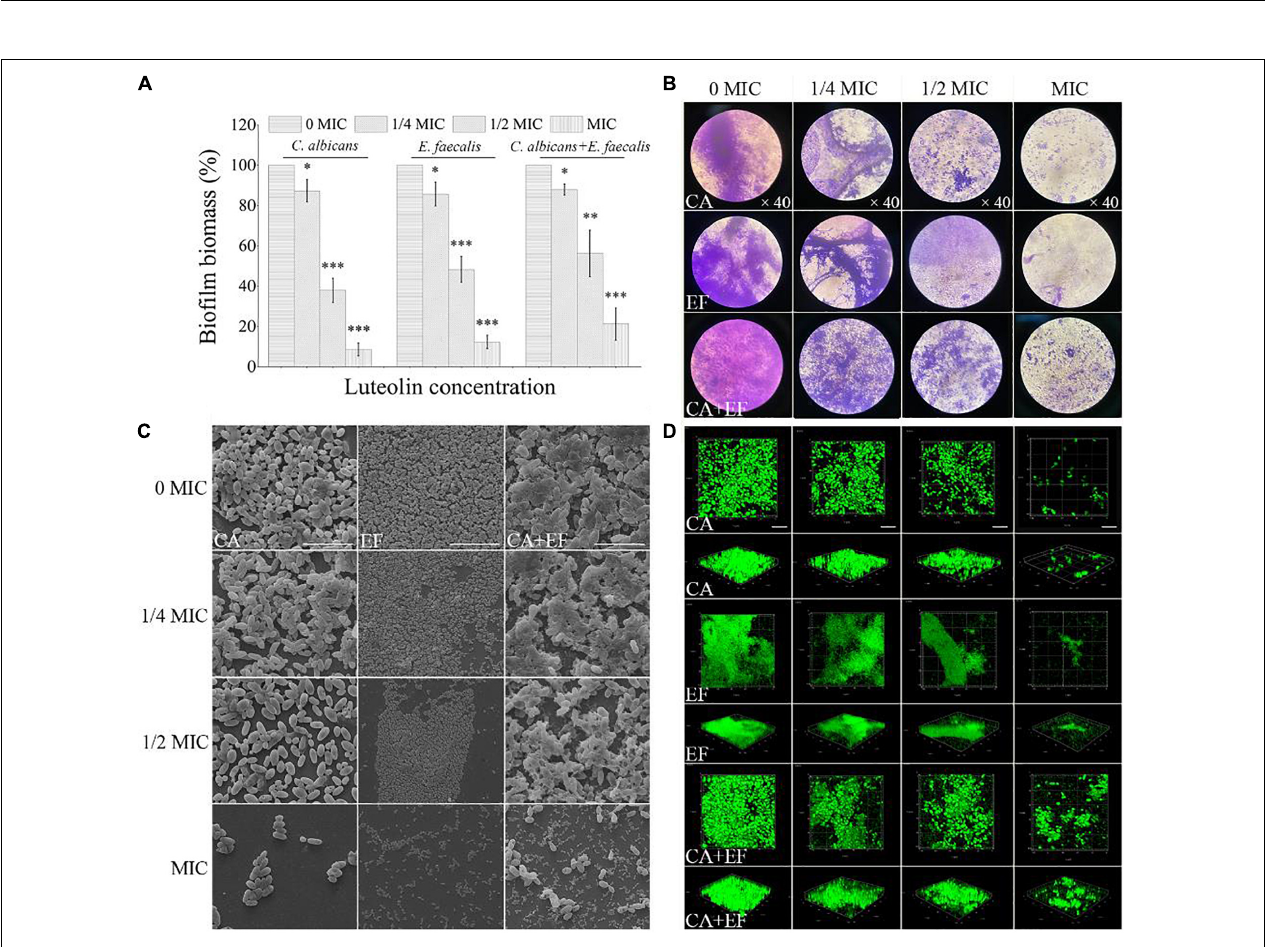
FIGURE 4 | Inhibitory effects of various concentrations of luteolin on the biofilm formation of C. albicans SC5314 (CA) and E. faecalis 20033 (EF) single and dual species (CA + EF) were determined using crystal violet staining assay (CVSA) (A) , optical microscope (B) , field emission scanning electron microscope (FESEM) (C) (scale bars of 20 µ m), and confocal laser scanning microscope (CLSM) (D) (scale bars of 20 µ m). Values represent the means of triplicate measurements. Scale bars represent the standard deviation (SD) ( n = 3). ∗ p < 0.05; ∗∗ p < 0.01; ∗∗∗ p < 0.001.